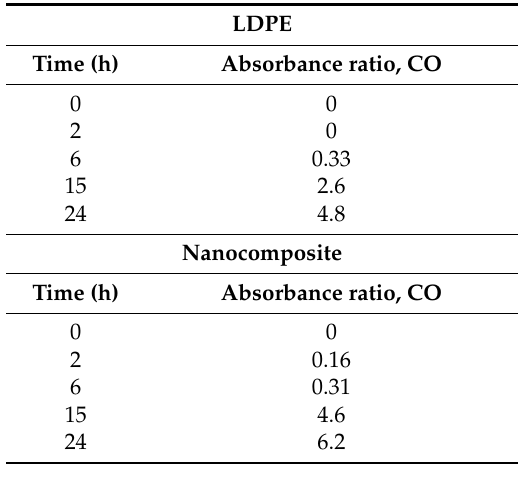
Table 2. Absorbance ratio, in the carbonyl region, of irradiated samples at given exposure times for LDPE and nanocomposite sample.